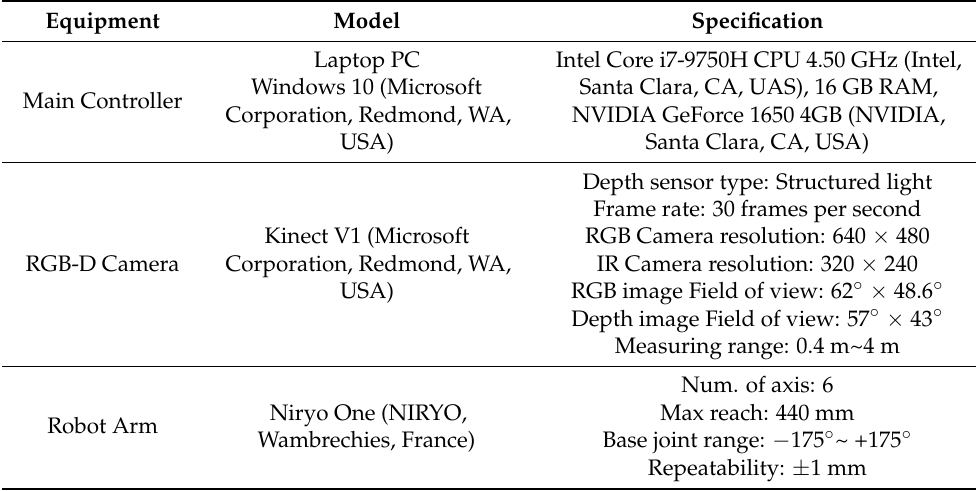
Figure 3. System architecture of data processing for the proposed smart hopper system. Table 1. Specification of sensors, the controller used in this study.